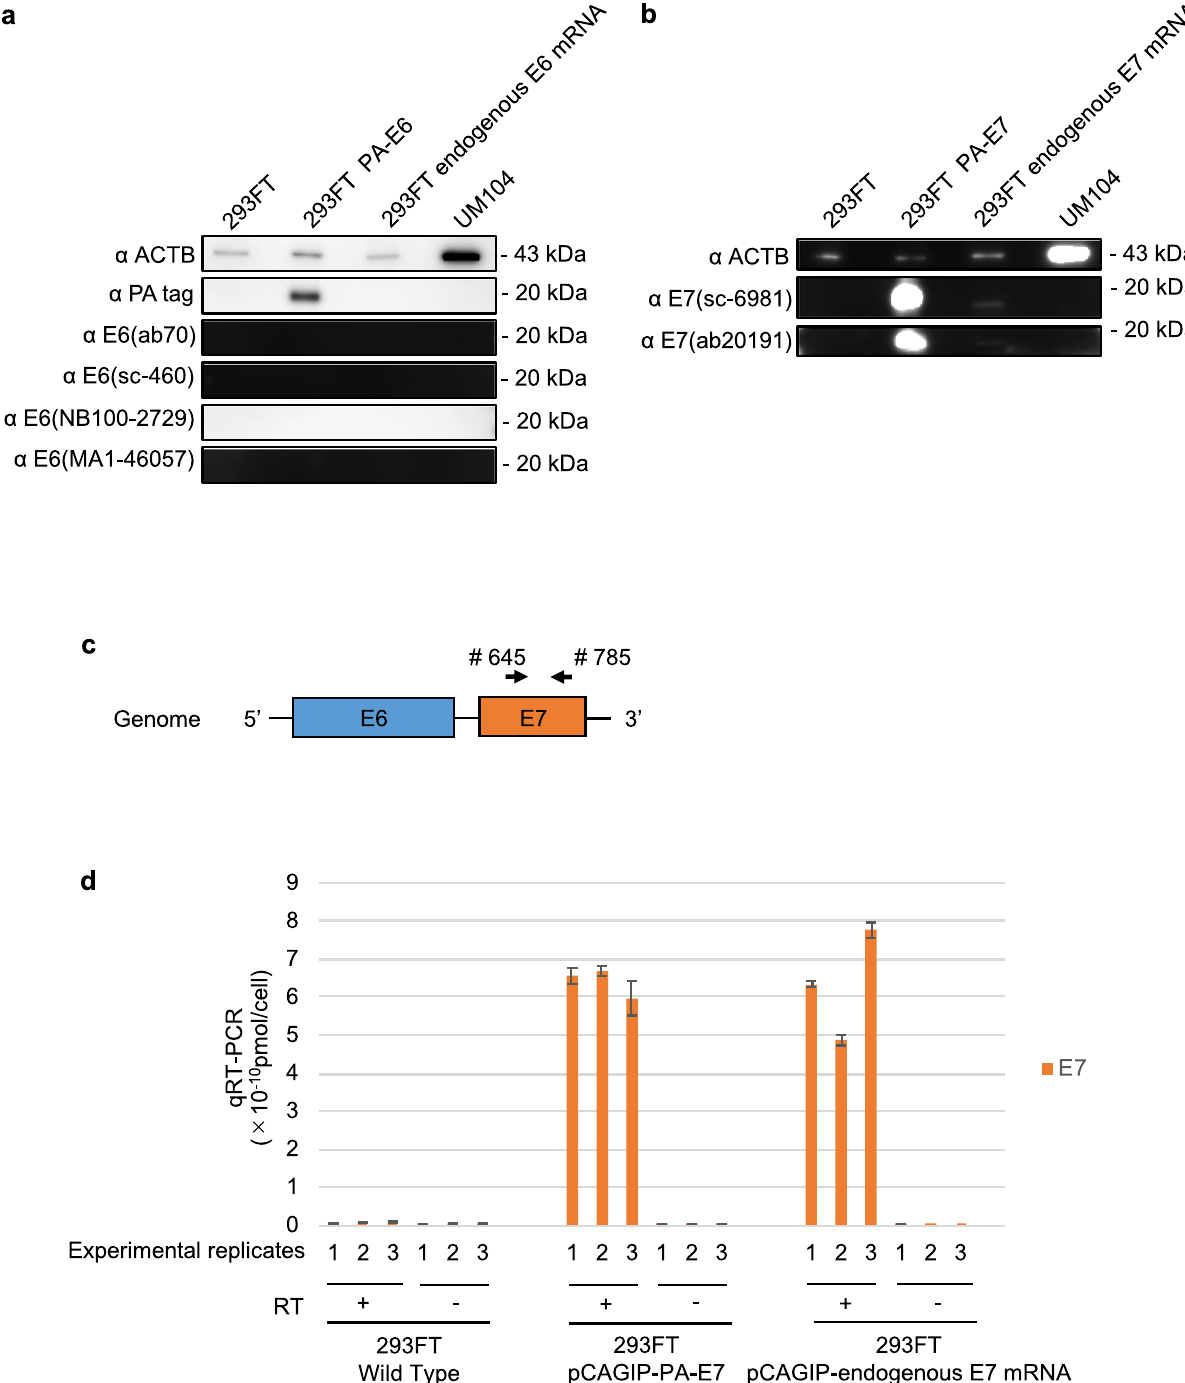
Figure 6. E7 protein expression in 293FT cells by overexpression of E7 mRNA having the endogenous structure. ( a , b ) Western blotting of E6 ( a ) and E7 protein ( b ) in 293FT cells (wild-type), 293FT cells transfected with pCAGIP-PA-E6/-PA-E7 or pCAGIP-endogenous E6/E7 mRNA, and UM104 cells. ( c ) E7 primers (# 645 and # 785) designed for binding within the E7 gene for use in qRT-PCR. ( d ) qRT-PCR analysis of E7 expression in 293 FT cells transfected with pCAGIP-PA-E7 or -endogenous E7 mRNA plasmids. The values for E7 expression per cell are shown. RT+, Reactions performed in the presence of reverse transcriptase. RT−, reactions performed in the absence of reverse transcriptase. The numbers on the x-axis show the experimental